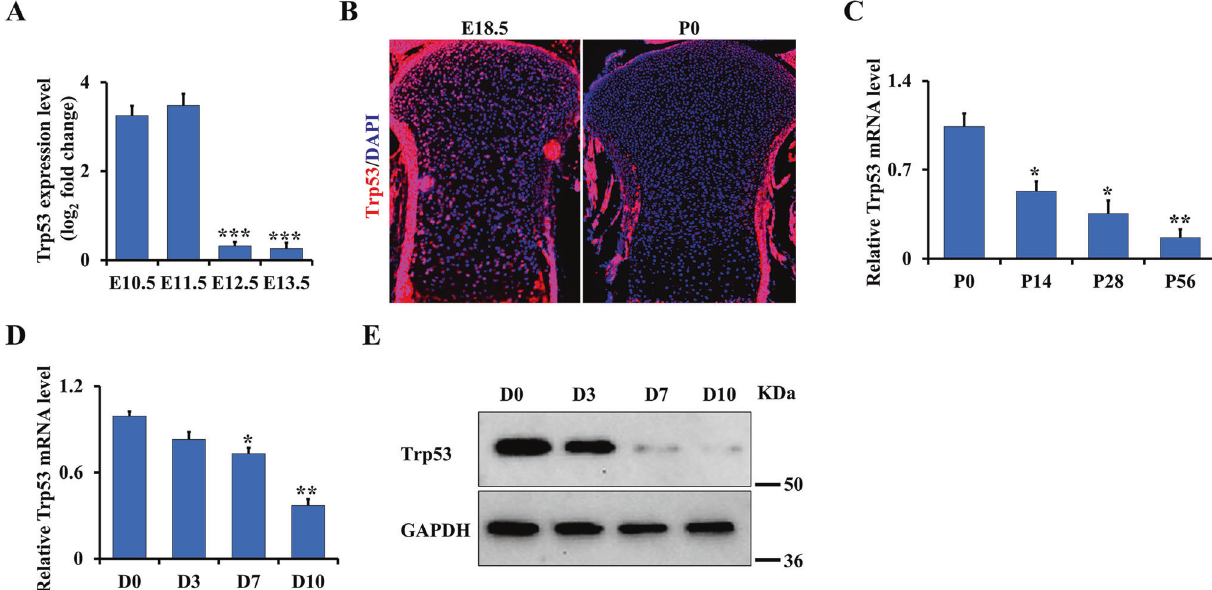
Fig. 1 Trp53 signature is gradually decreased during chondrogenesis and embryonic bone development. A Trp53 expression was identi fi ed in the primary chondrocytes using the publicly available early murine limb development data from GSE30138 [29] as indicated. E: embryonic day. B Representative immuno fl uorescent image of Trp53 in the tibia from wild-type mice as shown. P0: the newborn. Scale bars, 75 μ m. C Trp53 expression in cartilage as indicated. P: postnatal day. D , E Trp53 expression was determined by qRT-PCR and western blot after culture as indicated time in chondrogenic differentiation medium. D: day. * P < 0.05, ** P < 0.01, *** P <